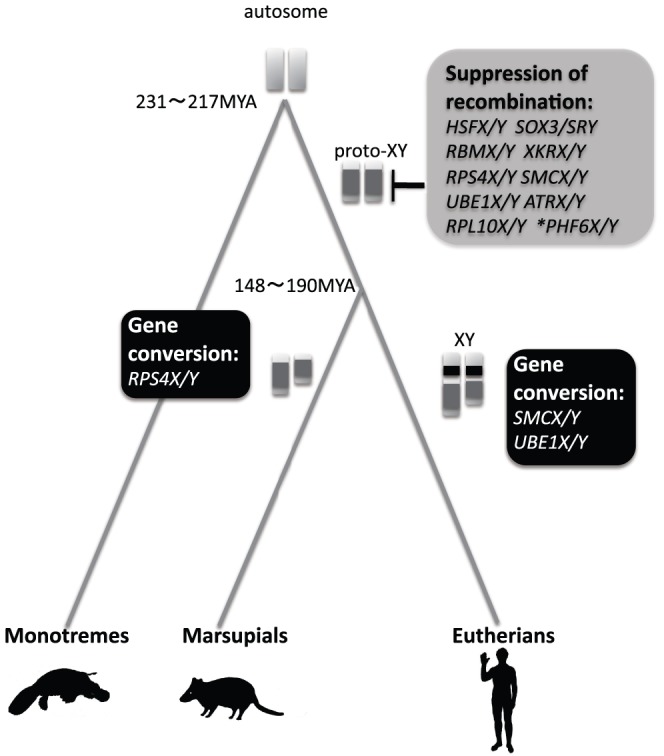
Schematic diagram of sex chromosome evolution in Theria.After the divergence of Theria from monotremes, recombination was suppressed in at least 10 genes on the proto-XY chromosome in the therian ancestor; this is indicated by gray color on the chromosome. In the stem lineage of marsupials and eutherians, a gene conversion occurred in RPS4X/Y or both SMCX/Y and UBE1X/Y, respectively; this is indicated by back color on the chromosome. An asterisk means that it is not clear whether PHF6X/Y diverged at the same time as the differentiation of the other gametologs (see text).